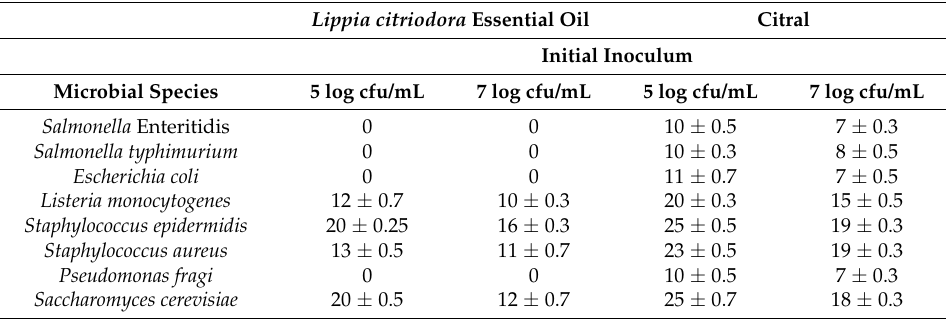
Table 2. Antimicrobial activity of the Lippia citriodora essential oil against common food spoilage and pathogenic microbes monitored by the disk diffusion